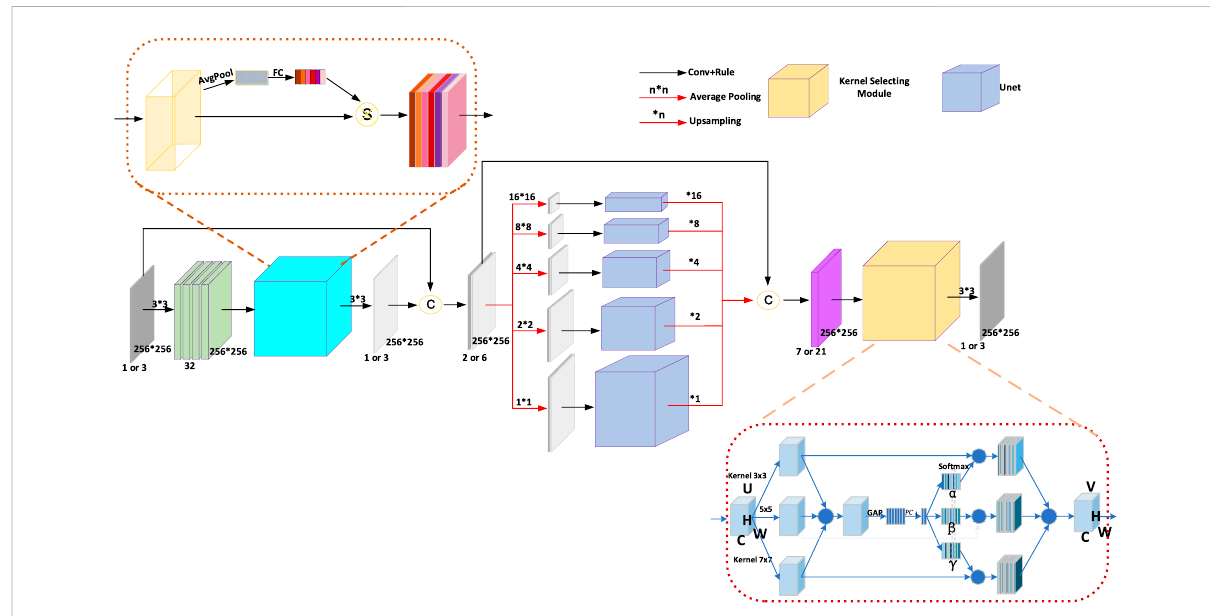
FIGURE 3 The architecture of the Pyramid Real Image Denoising Network (PRIDNet). The number of channels of the feature maps is shown below them; the symbol C indicates